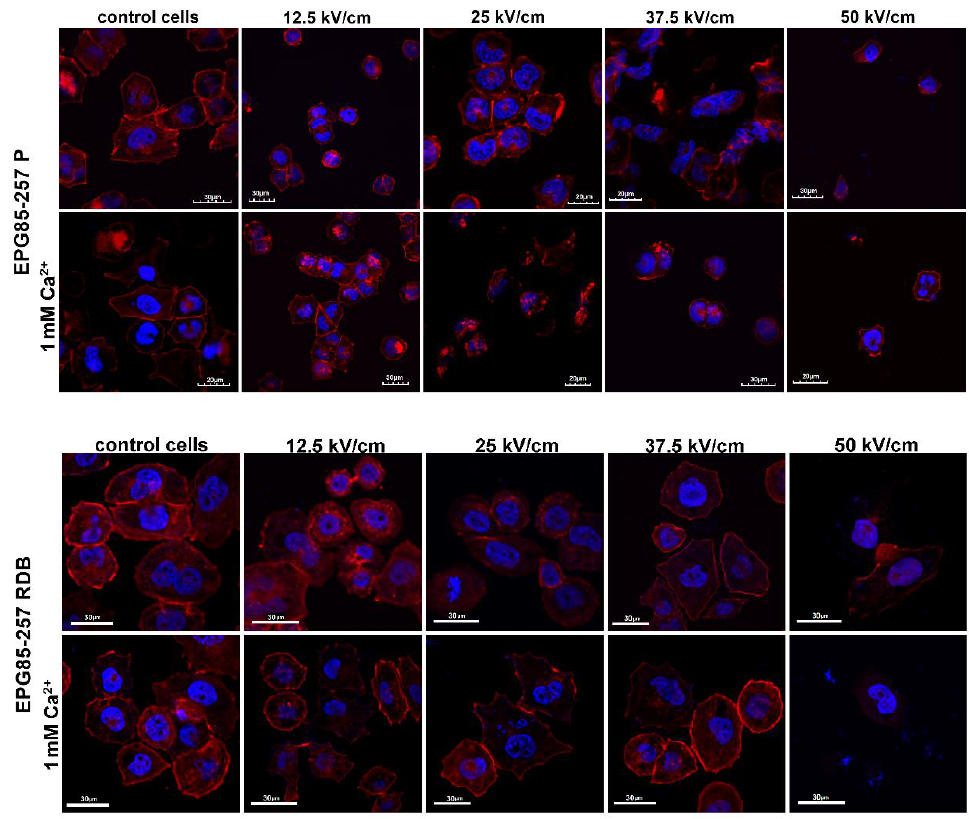
Figure 4. The evaluation of cytoskeleton protein, F-actin ( red ), and nuclei ( blue ) after 24 h in human gastric cells, after the exposure to nsPEFs with or without calcium ions (1 mM), Note: F-actin-red; nuclei — blue.